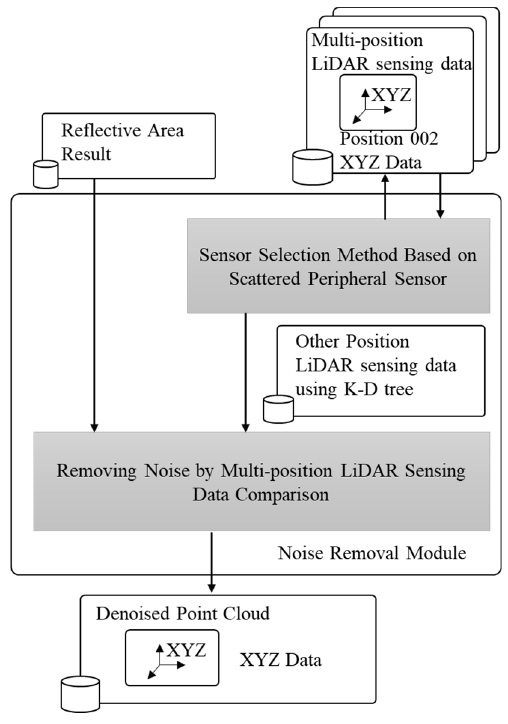
Figure 10. Overview of the noise removal module.